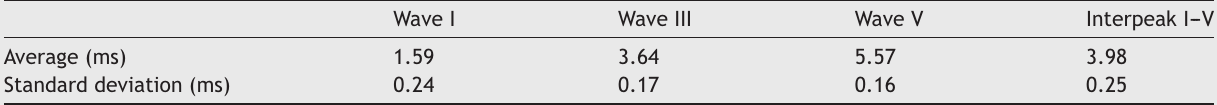
Table 1 Pattern of normality of latency and interpeak values of BAER for adults, proposed by the manual of Smart EP --- IHS. Wave I Wave